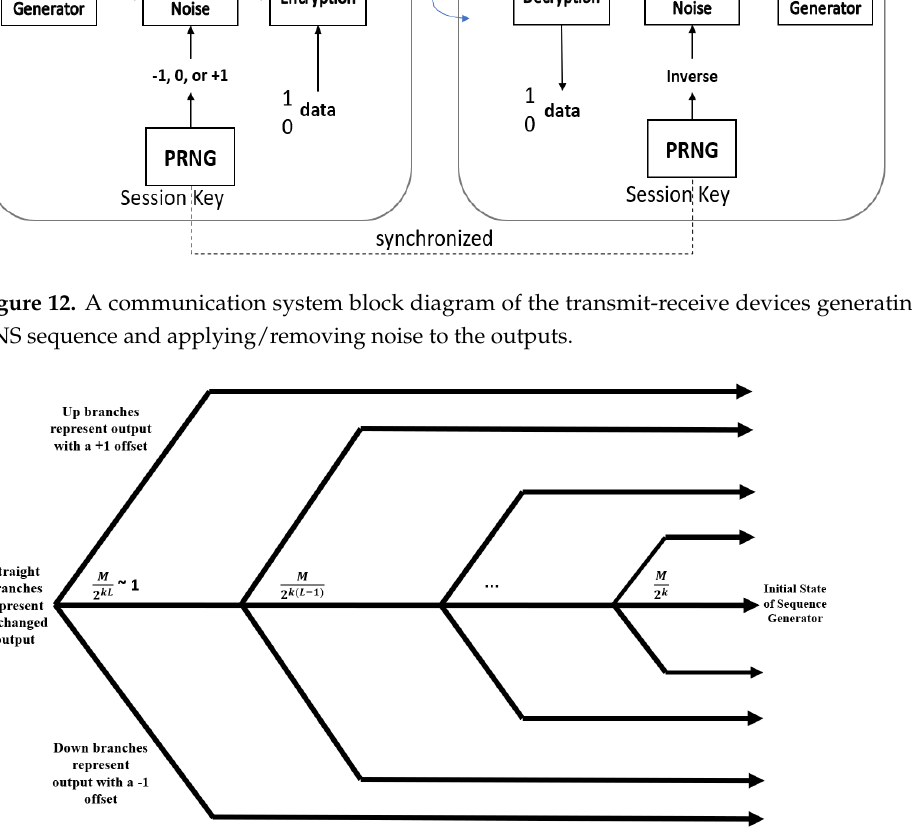
Figure 13. Fishbone diagram displaying a visual of the possible output branching when a single ± 1 error